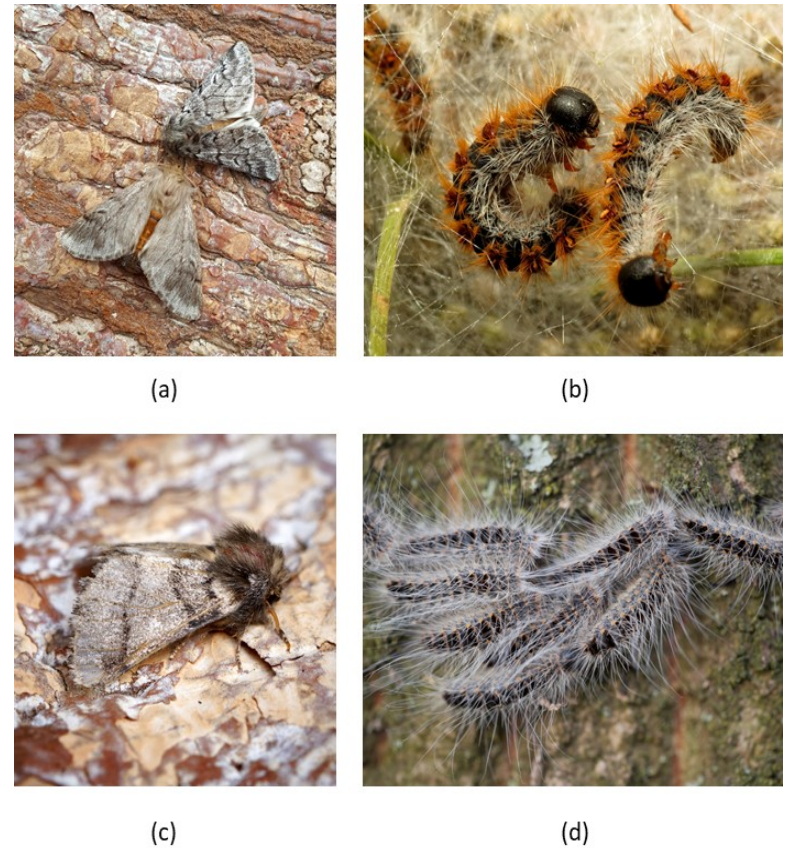
Figure 1. Pine processionary moths (PPM) and oak processionary moths (OPM) in their natural habitat. ( a ) A pair of PPM adults on the bark of a tree; ( b ) PPM caterpillars on their silk nest amongst pine needles; ( c ) OPM adult on a tree; ( d ) Procession of OPM caterpillars on the bark of an oak tree. All ( a – c ) or CC-BY-SA-4.0 ( d ). (photos a and c, Ben Sale; b, Katja Schulz; d, Luc